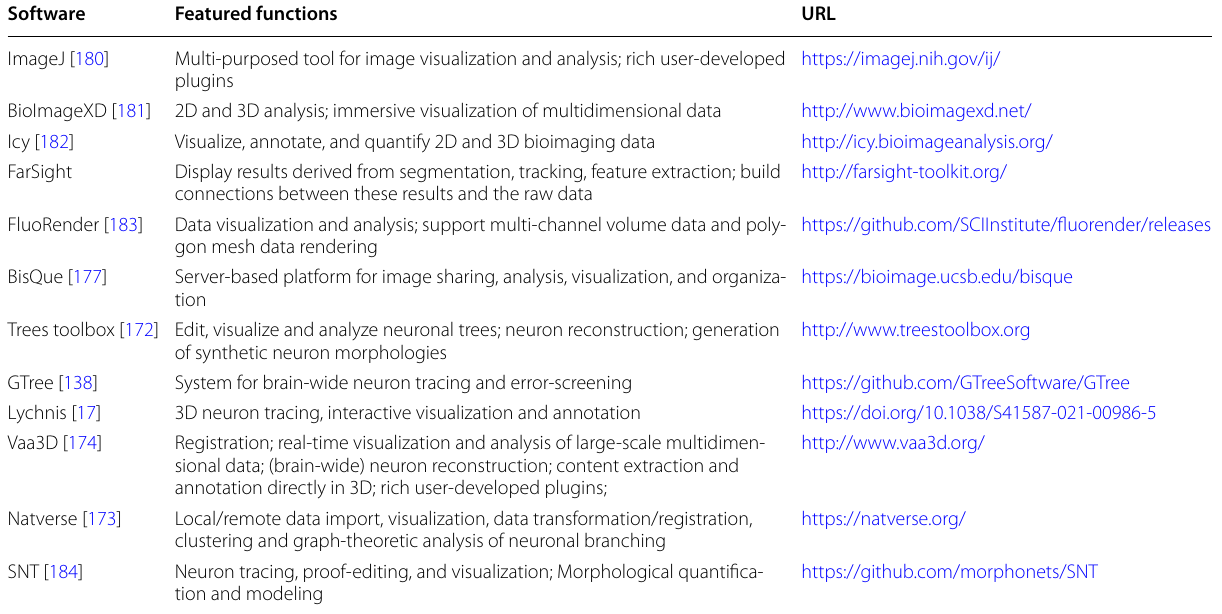
Table 2 Typical open-source platforms for data processing